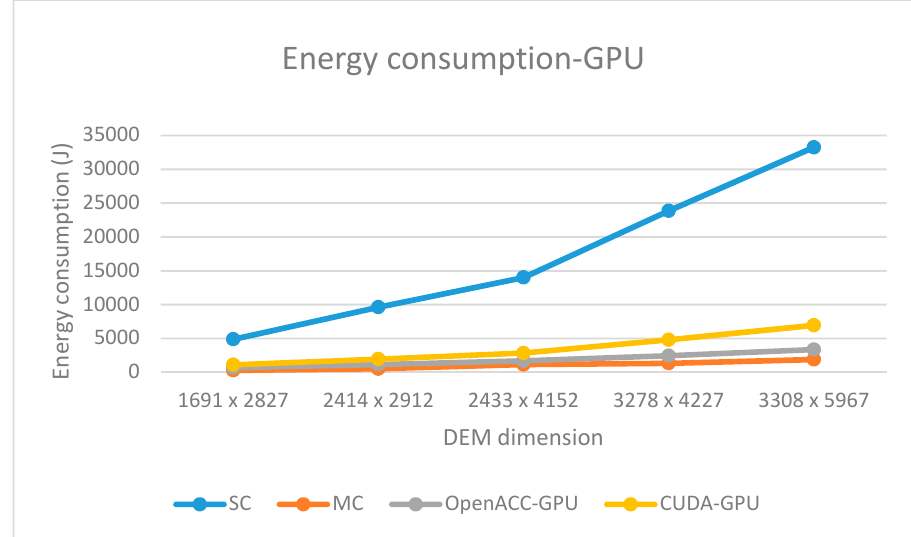
Figure 11. Energy consumption GPU ‐ Tesla K80.